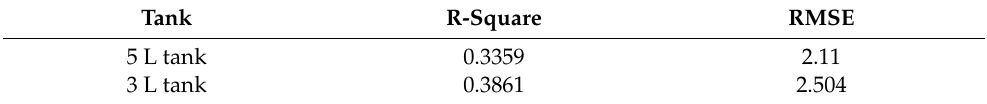
Table 4. Goodness of fit of flow index model.